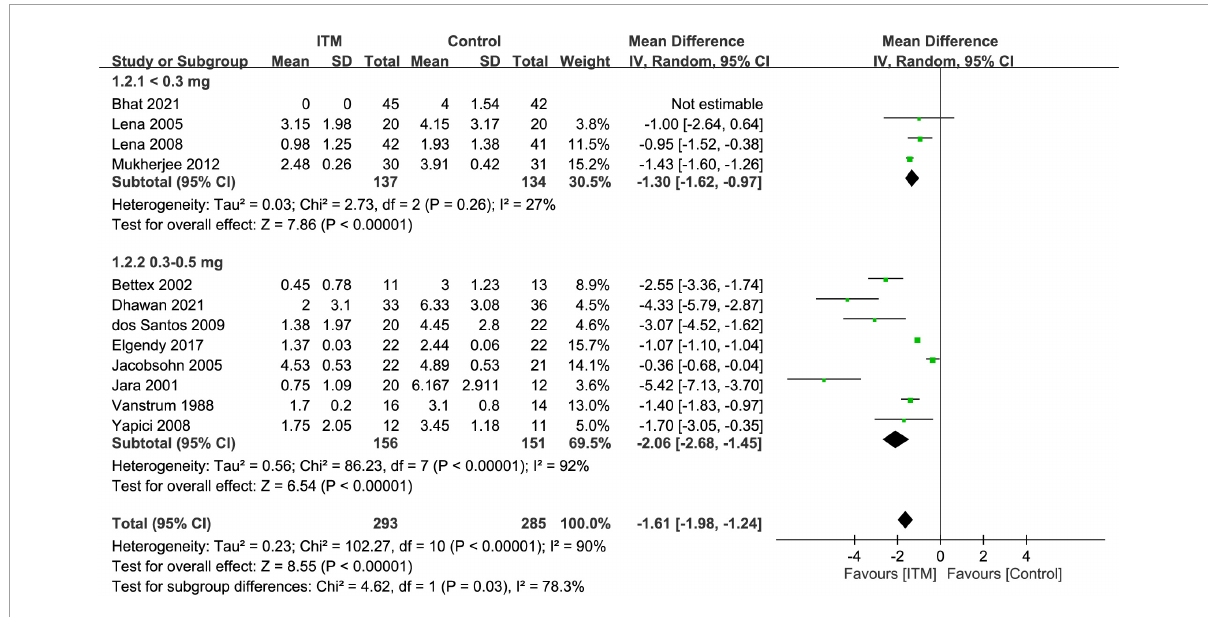
FIGURE3 Forest plot comparing the pain score at postoperative 24 h between intrathecal morphine (ITM) and control groups. CI, confidence interval; IV, inverse variance; SD, standard deviation.